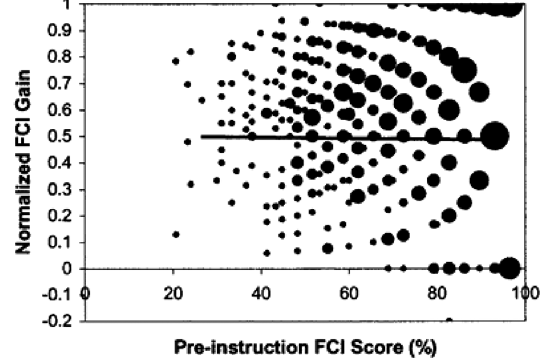
FIG. 1. At Harvard, individual students ’ normalized gain is not correlated with FCI prescore ( r ¼ 0 , N ¼ 670 ). For example, the average of the individual normalized gains for the 20 Harvard students with the lowest prescores was 0.6, the same as the average normalized gain for students with higher prescores [5]. The largest dot represents 19